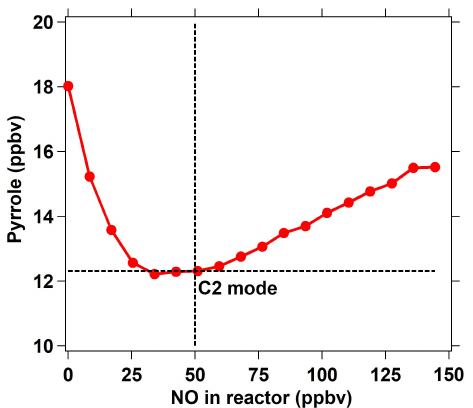
Figure 2. The response of the pyrrole concentration to different NO concentrations introduced through arm G into the reactor. For the ICRM system, the C2 mode corresponds to a pyrrole concentration of 12.31ppbv at NO = 50ppbv, at which the HO 2 radicals were constantly